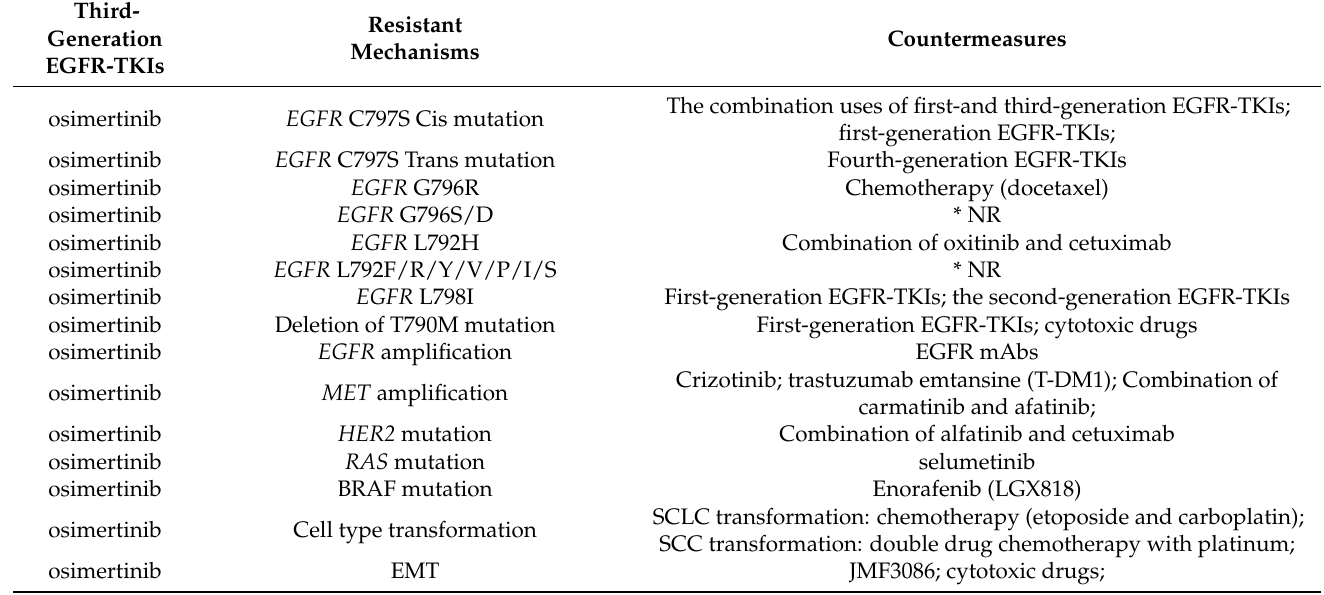
Table 3. Mechanisms and treatment strategies for resistance to